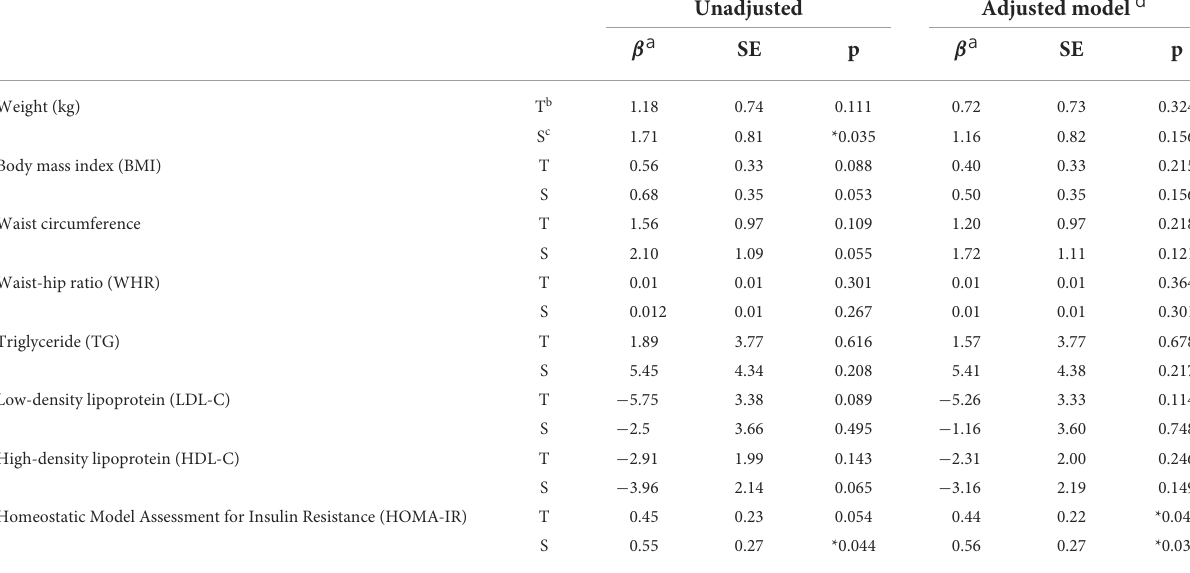
TABLE 4 Linear regression for associations between maternal shift work during pregnancy and health outcome of children at 7-year-old follow-up. Unadjusted Adjusted model